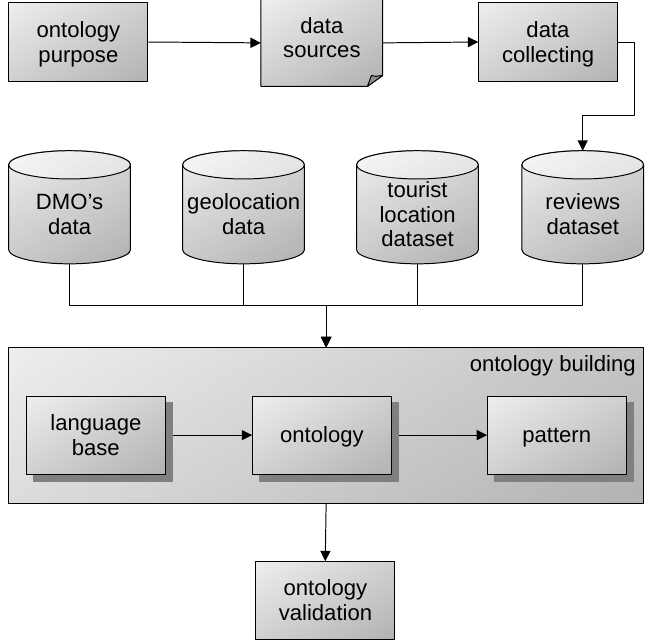
Figure 4. OntoTouTra development